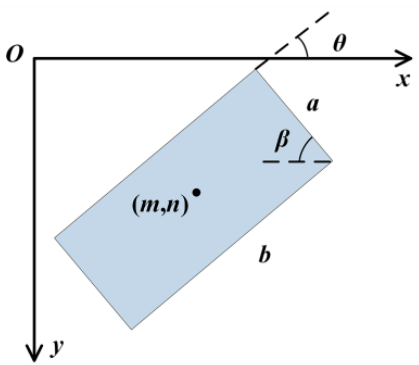
Figure 13. The process of calculating the angle: ( a ) the cropped image; ( b ) gray scale; ( c ) canny edge extraction; ( d ) extraction of contour points; ( e ) calculation of convex hull; ( f ) minimum bounding rectangle.